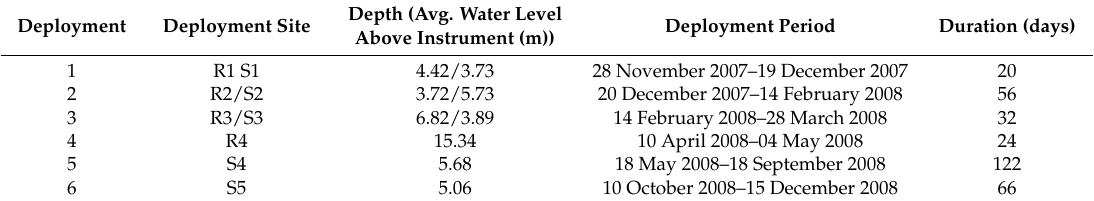
Table 1. Summary of ADCP deployment depths, periods and duration. Deployment sites beginning with R represent the RDI 1200 Hz Workhorse Sentinel ADCP and S the SonTek 1500 Hz ADCP. Depth (Avg. Water Level Deployment Deployment Site Above Instrument